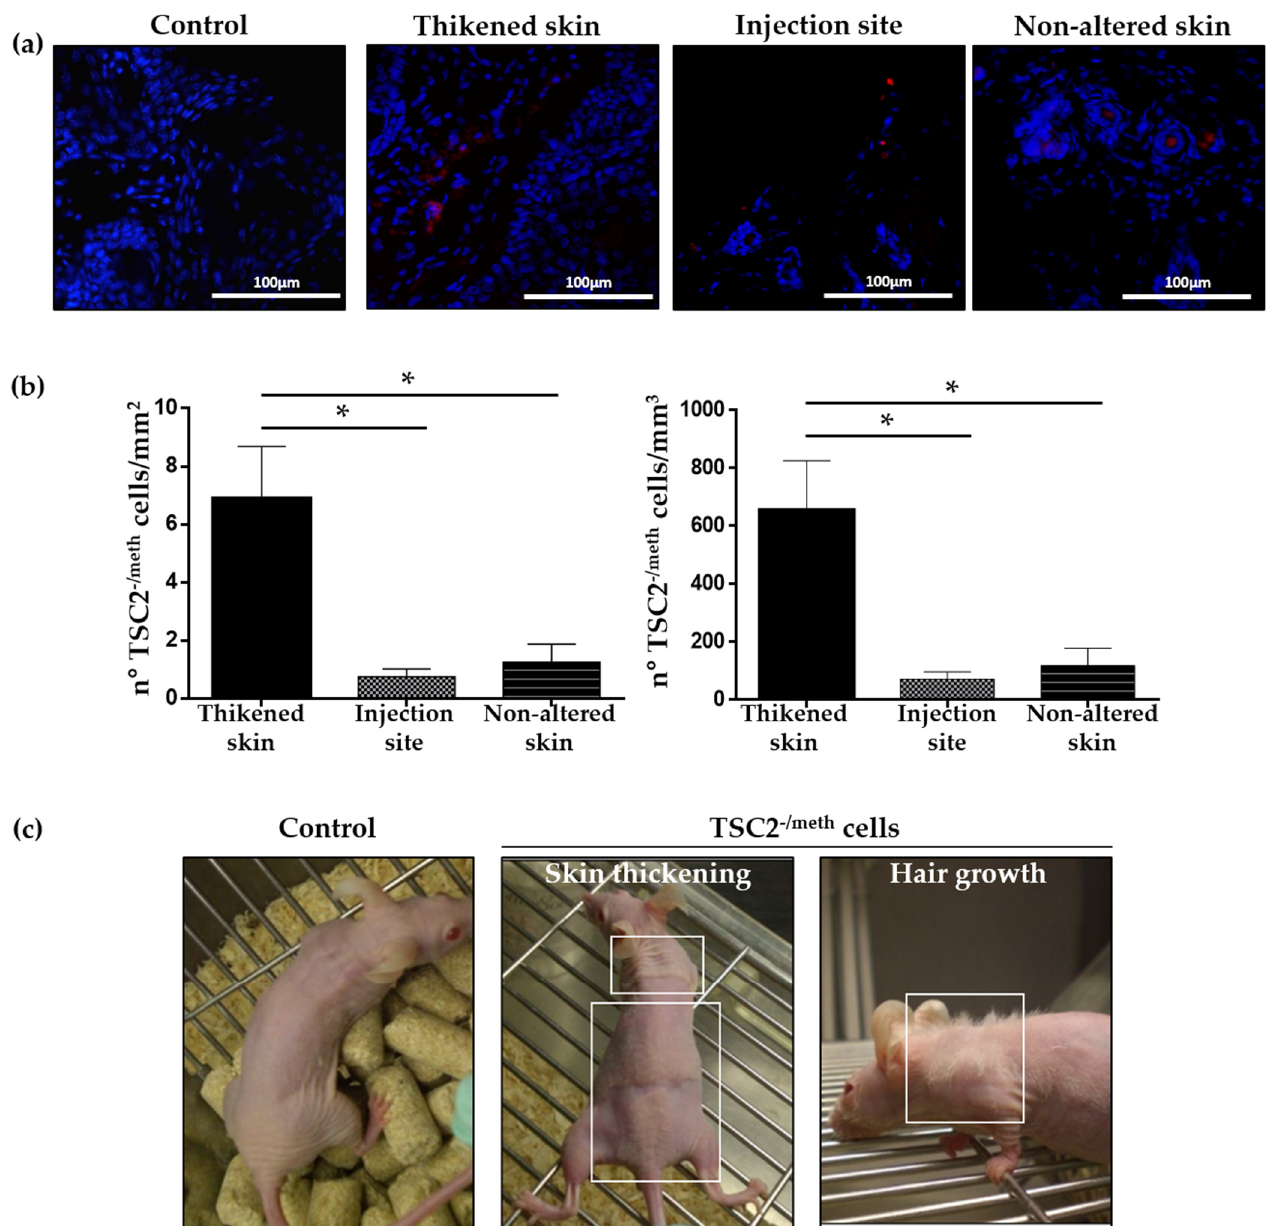
Figure 1. ( a ) Representative images of PKH26-labeled cells (red) detected in the skin of mice 60 days after the injection. Control mice were not injected with TSC2 -/meth cells. Nuclei were stained with DAPI. Scale bar: 100 µm ( b ) Quantification of the skin invasion by TSC2 -/meth cells in different areas. Data are shown as number of PKH26-labeled cells per millimeter squared (left panel) or as number of PKH26-labeled cells per millimeter cubed (right panel). ANOVA with Tukey’s test. * p < 0.05, results are shown as mean ± SEM ( c ) Representative images of skin lesions observed in mice after 60 days from subcutaneous injection of TSC2 -/meth cells. White squares highlight thickened areas and hair growth.